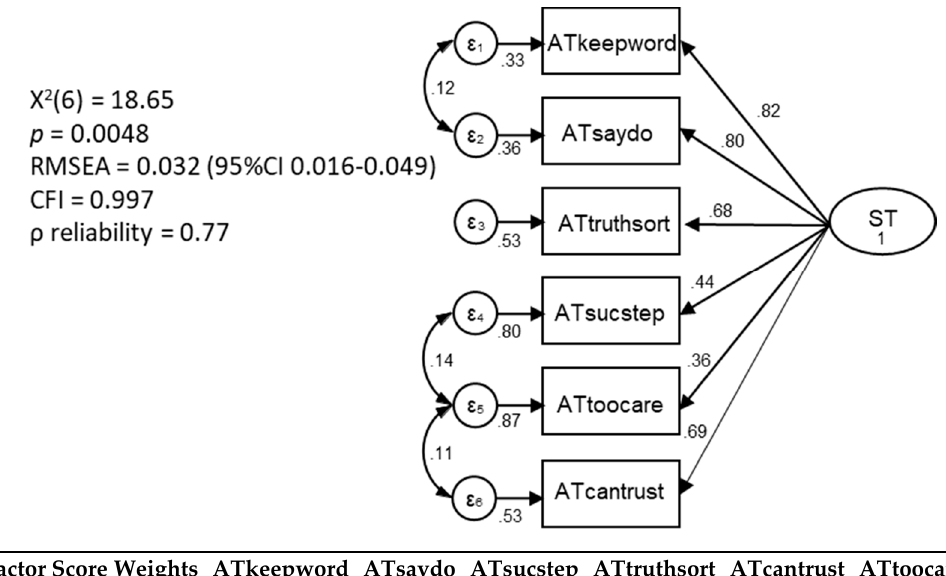
Figure A5. Final model for Social Trust construct of personal social cohesion.